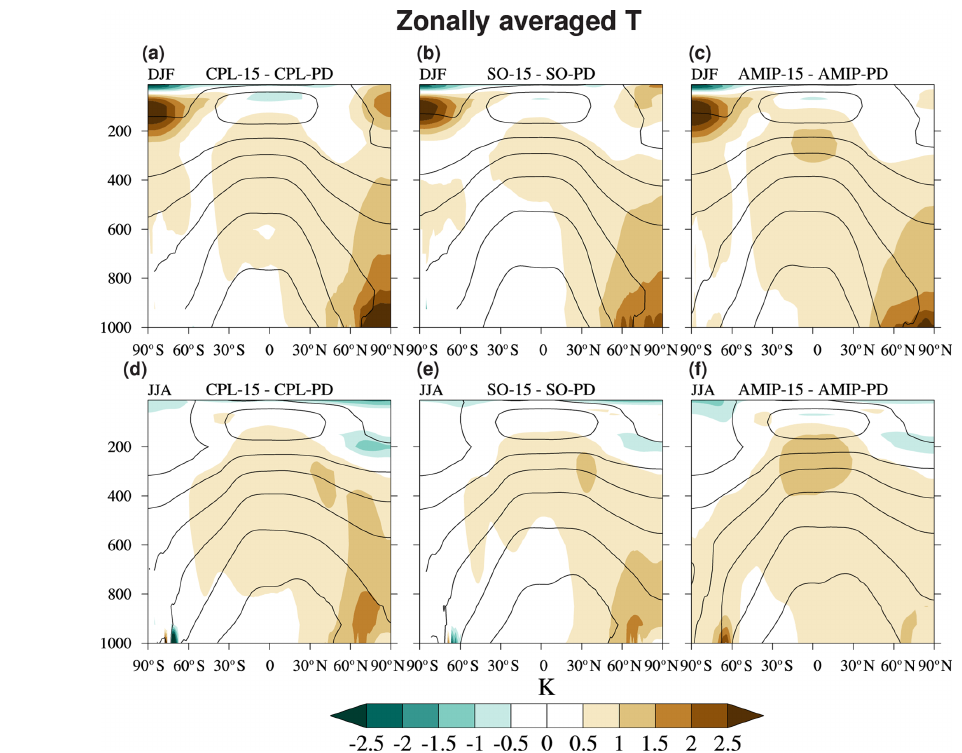
Figure 9. Zonal-mean temperature response relative to PD (colours) and climatology (solid black contours; 210 to 285K in increments of 15K) for the 1.5 ◦ C experiment from NorESM1-Happi (a, d) , NorESM1-HappiSO (b, e) , and NorESM1-HappiAMIP (c, f) . Fields are shown for DJF (a–c) and JJA (d–f) for the default periods given in Sect. 3. Units are in Kelvin (a–f)